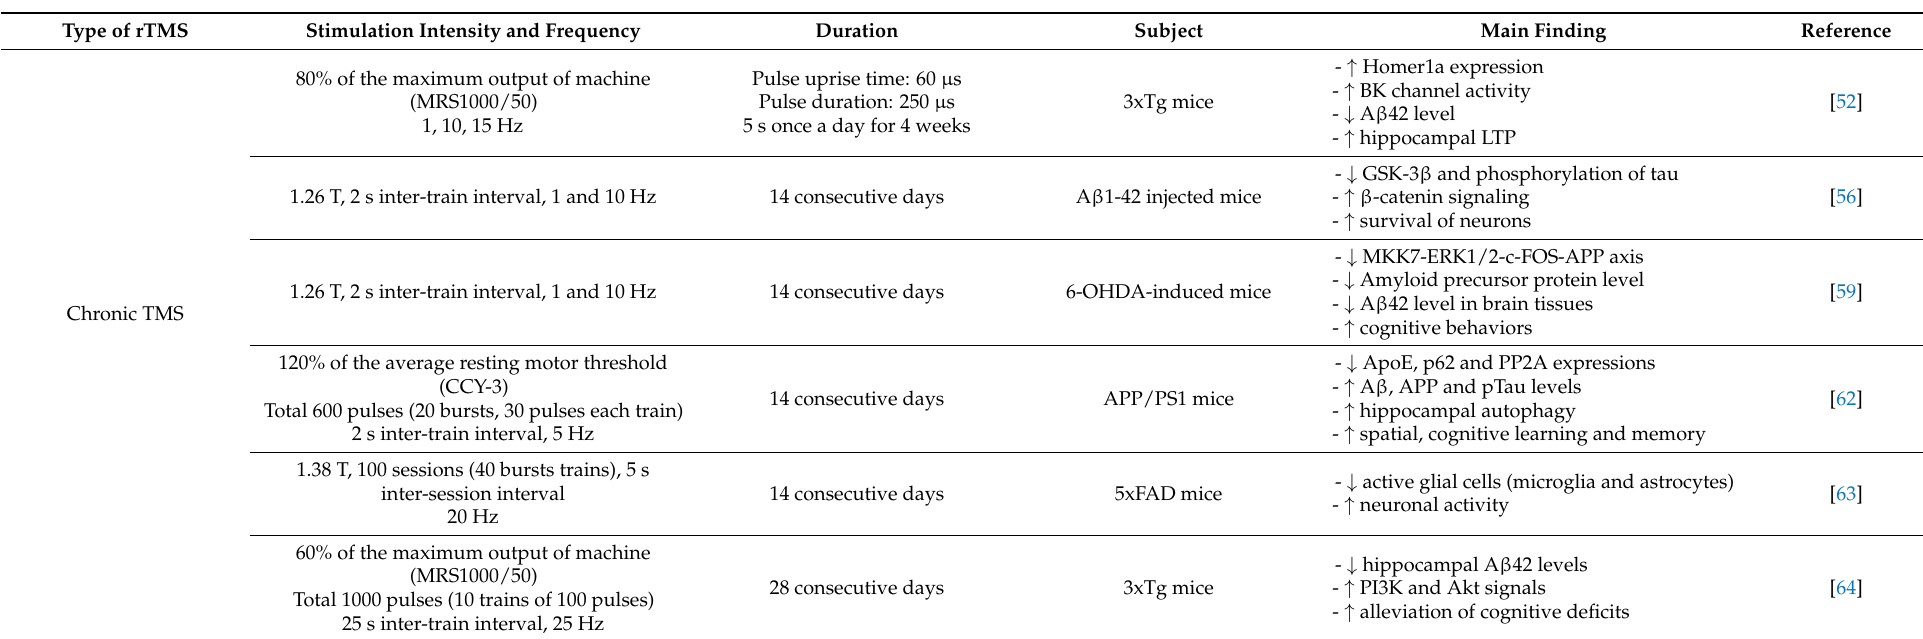
Table 2. A summary of rTMS on A β and tau